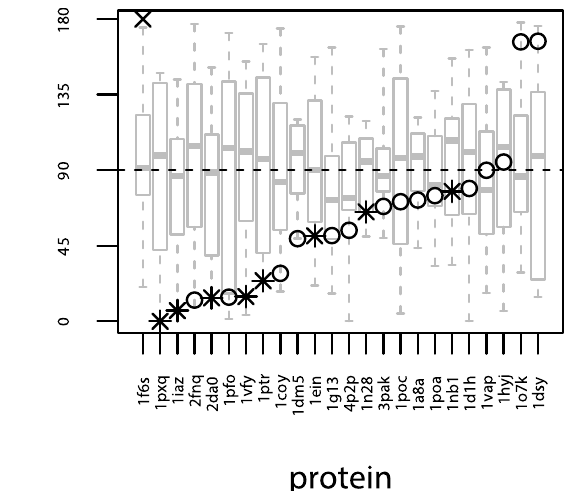
Fig 7. Protruding hydrophobes predict experimentally verified binding sites. The figure shows comparisons of predicted binding residues (‘the Likely Inserted Hydrophobe’) with experimentally verified binding sites for a manually curated dataset of 24 proteins (listed in S2 Table). The vertical axis corresponds to values of the angle (Eq 11) comparing the two vectors connecting the center of the protein with either the predicted or known binding sites. Smaller angles imply better agreement between prediction and experiment. Asterisks ( (cid:3) ) mark proteins where the Likely Inserted Hydrophobe is an amino acid experimentally identified to be interacting with the membrane. The grey boxplots show the distribution of angles when the known binding site residues are compared to all protruding amino acids on the protein. 1iaz is analysed in its soluble monomeric state, while it forms a transmembrane pore upon oligomerisation. The structure of the Bovine α -lactalbumin (PDBID: 1F6S) has no identified protruding hydrophobes and is marked with a cross at 180˚.